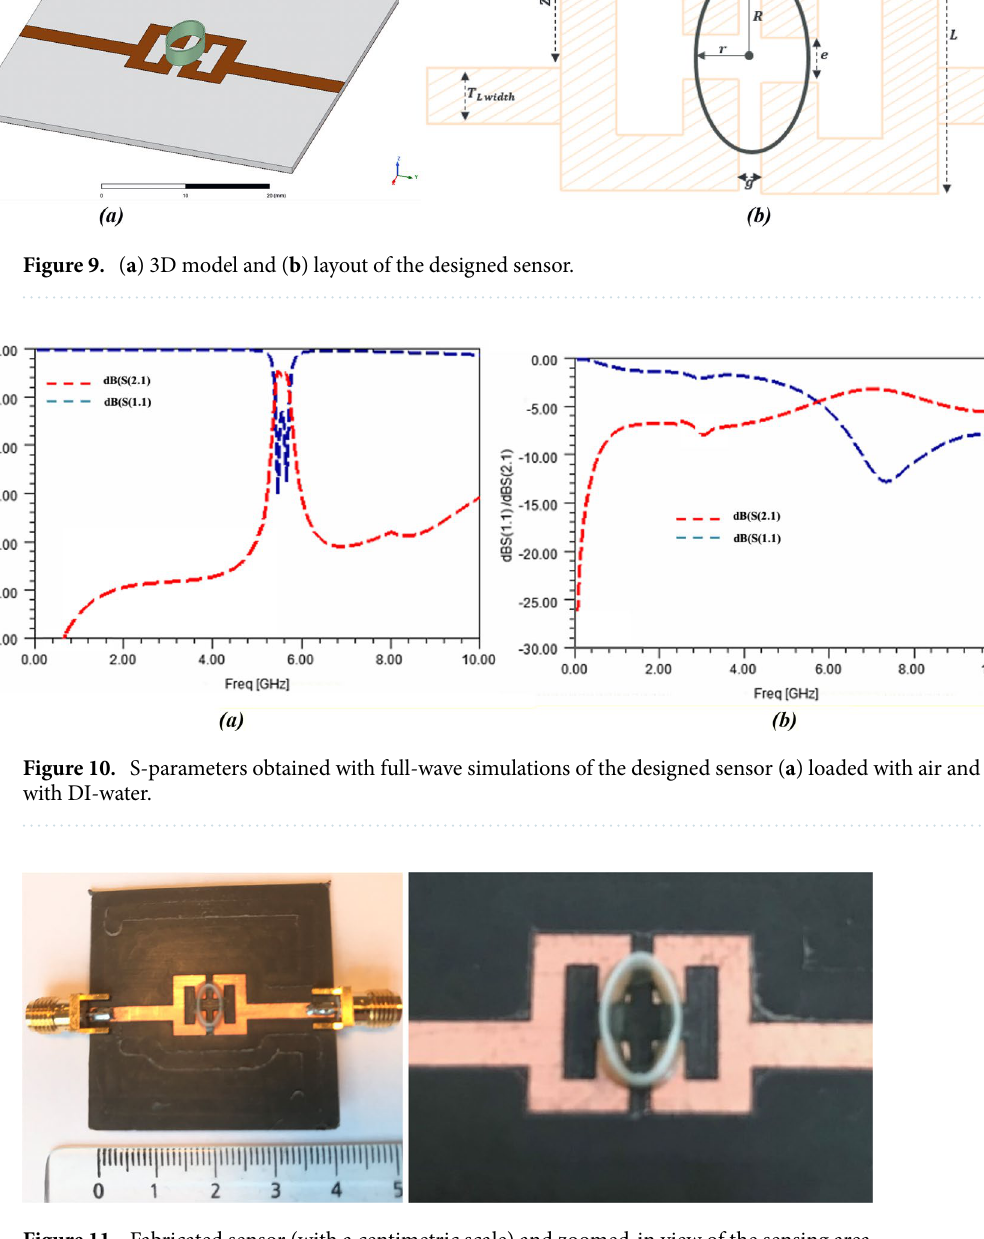
Fig. 12a together with the simulated and measured results when the container is filled with DI-water (A0 solu- tion), which are presented in Fig. 12b. As it can be noted from Fig. 12, simulations of the initial model of the sensor are slightly different from measurements. It means that the proposed 3D-model of the sensor does not fit exactly the measurements of the realized sensor, the differences, mainly a frequency shift, can be attributed to inaccurate material description or technological dispersions. Concerning those latter ones, they can be related to machine tolerances or deviations, which could impact metal etching or container size. Technological dispersions may also be due to the manmade gluing of the container, entailing uncertainties upon the size of the final glue tie and the container position. To consider all those dispersions, retrofitting electromagnetic simulations were run to refine the sensor model trying to make its simulations fit both the air and DI-water measurements. Sensitive design parameters were identified and tuned. The modified dimensions are g = 1.6 mm and size of the bottomless container R = 3.31 mm